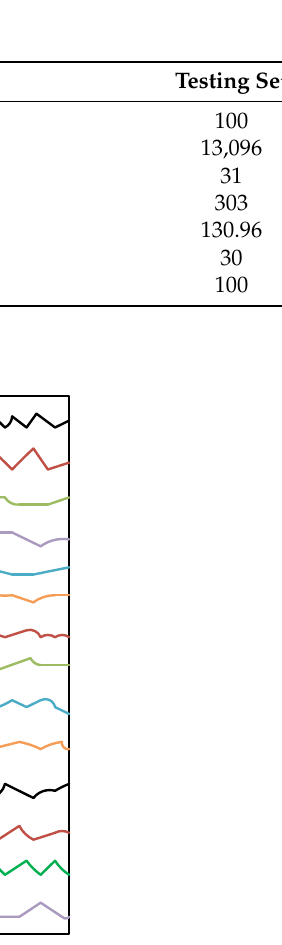
Figure 9. Illustration of one training sample with 14 selected features over a time window of length